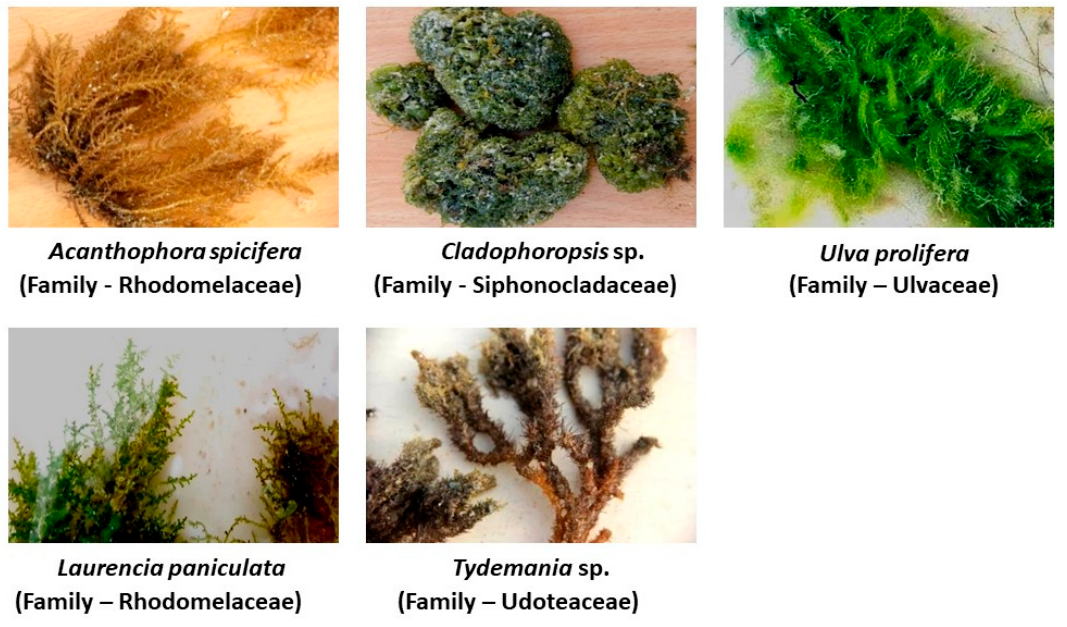
Figure 4. Aerial view of marine macroalgae collected from the rocky shore of Red sea coasts of Yanbu, Saudi Arabia.